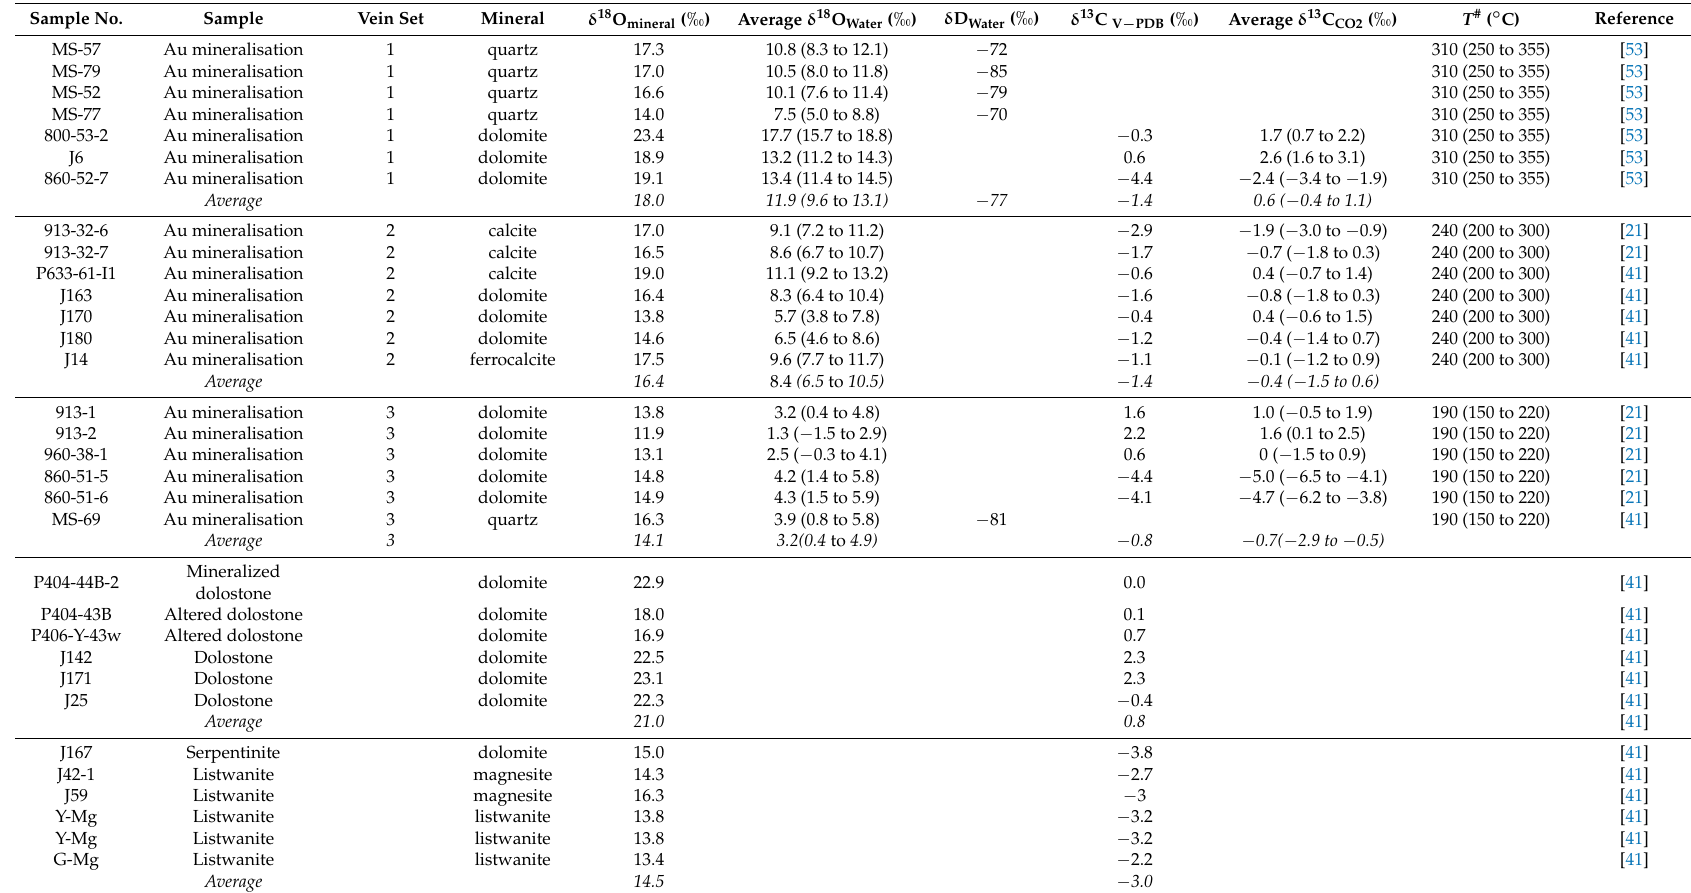
Table 2. C-H-O isotope composition of mineralisation at the Jianchaling Au deposit (modified from [21]). Sample